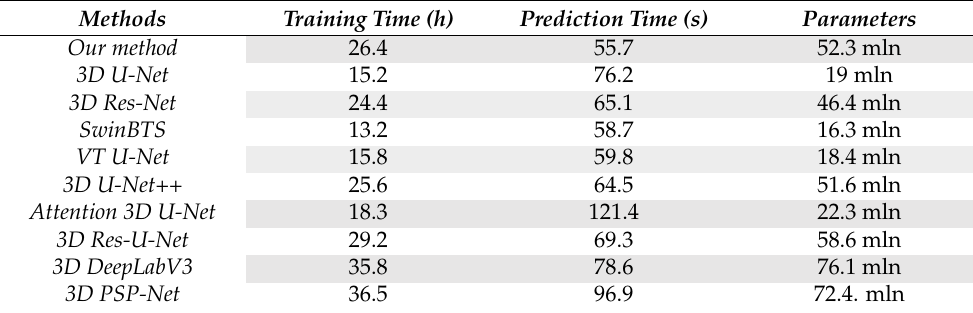
Table 2. Complexity of models used in comparison process.